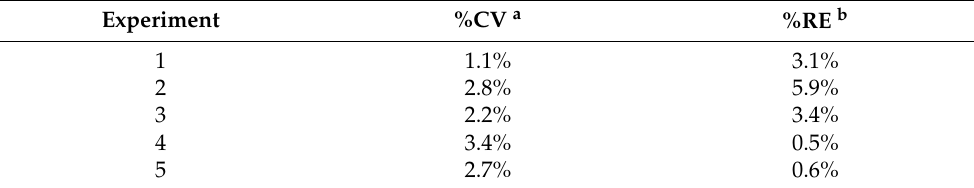
Table 6. System suitability